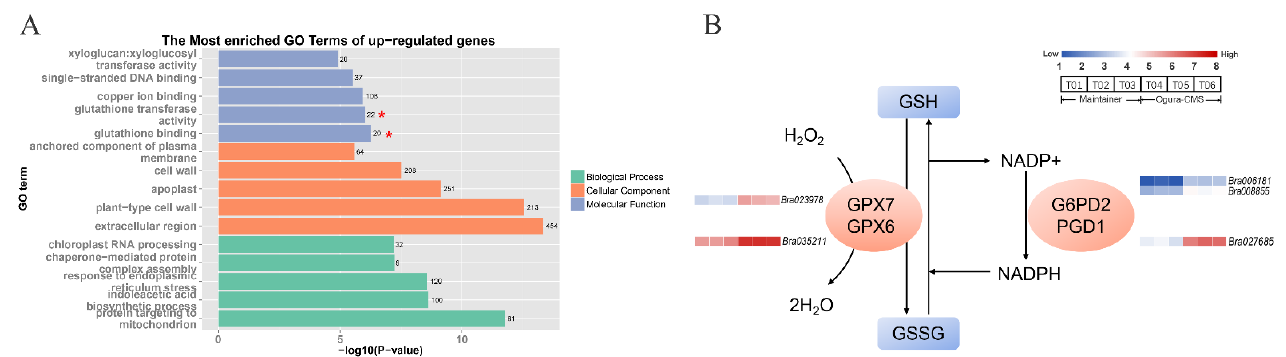
Figure 5. Enrichment analysis of genes up-regulated in the maintainer line vs. Ogura CMS line. ( A ) GO analysis of up-regulated DEGs; ( B ) part of the glutathione metabolic pathway. GSH, glutathione; GSSG, oxidized glutathione; G6PD2, glucose-6-phosphate dehydrogenase 2; PGD1, 6-phosphogluconate dehydrogenase 1; GPX7, glutathione peroxidase 7; GPX6, glutathione peroxidase 6. T01, T02 and T03 represented 3 libraries (the maintainer line, 3 times replication); T04, T05 and T06 represented 3 libraries (the Ogura CMS line, 3 times replication).